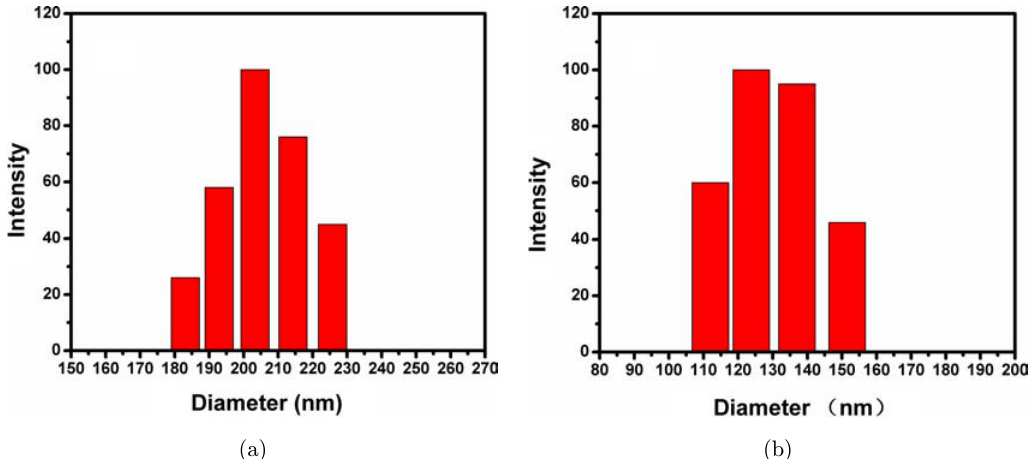
Fig. 1. The hydrodynamic diameters of (a) blank micelles and (b) ICG derivative-loaded PNIPAAm micelles in PBS determined by DLS.